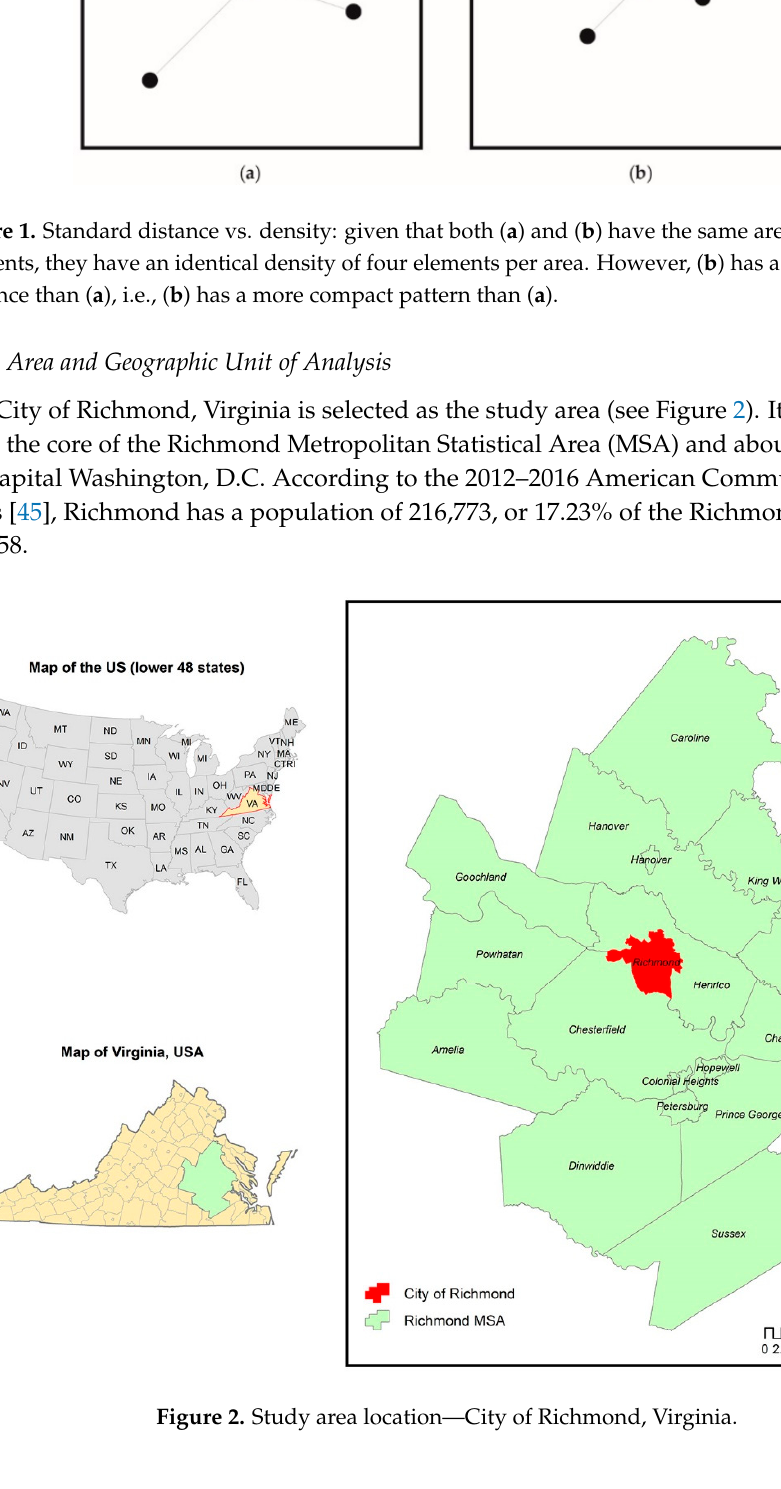
Figure 2. Study area location—City of Richmond, Virginia. The most granular geographic unit of the study is a parcel. In specific, I used the 2014 assessor’s database of the City of Richmond [46] to determine a parcel’s location and its use. Each parcel has two assessed values—land and improvement, and only parcels that have improvement assessment values are considered and they are referred in this study as developed parcels. I chose to use developed parcels to capture parcels that are already developed according to their land use designations. Parcels zoned for certain land uses but yet to be developed (i.e., without